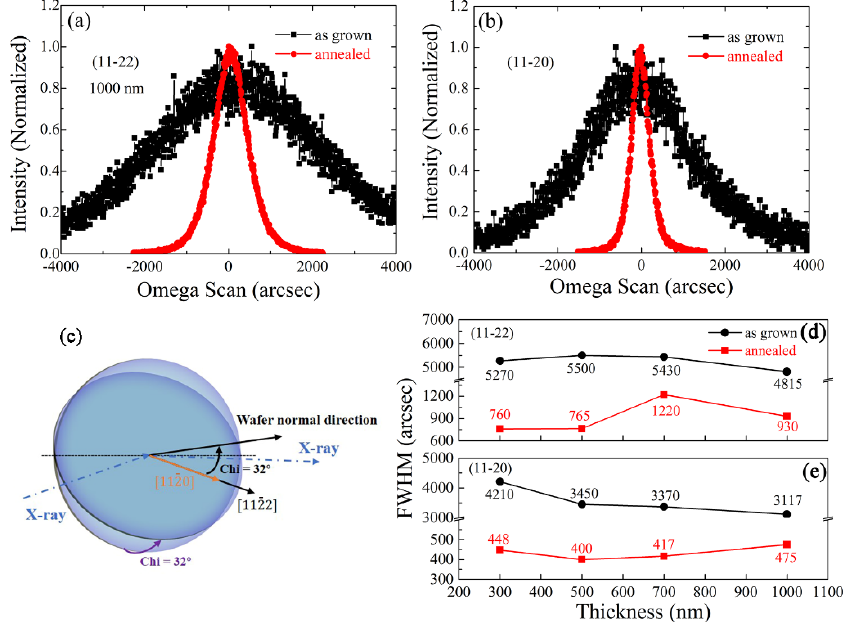
Figure 2. XRD rocking curves of ( a ) (11–22) and ( b ) (11-20) planes of 1000-nm-thick as-grown and annealed AlN samples; ( c ) the geometry of XRD-RC measurements of (11–22) and (11-20) planes; thickness-dependent FWHMs of ( d ) (11 – 22) and ( e ) (11-20) RC curves. The annealing duration is 5 h.